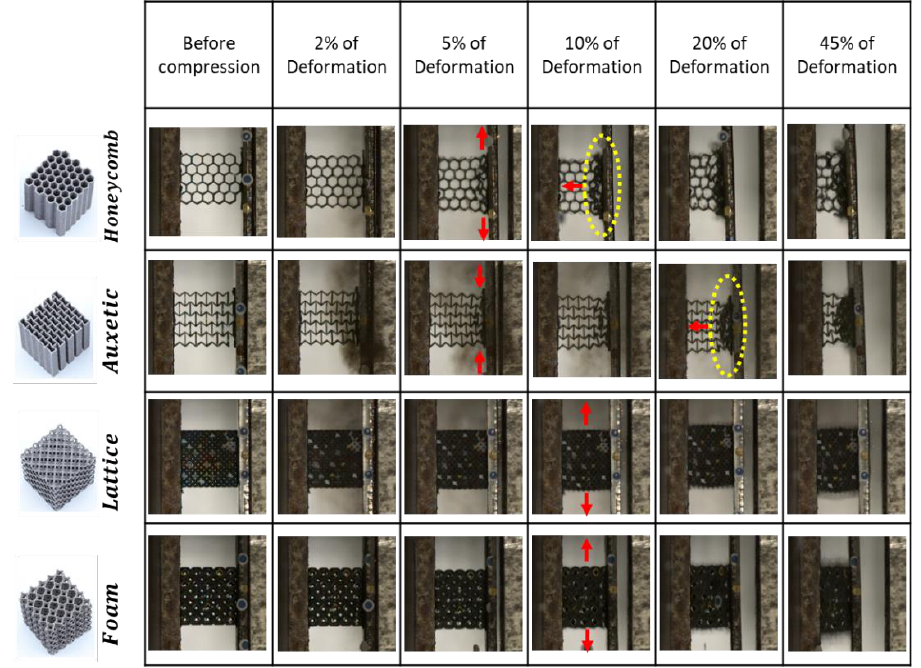
Fig. 4 . The subsequent frames recorded by a high-speed camera during the performed blast